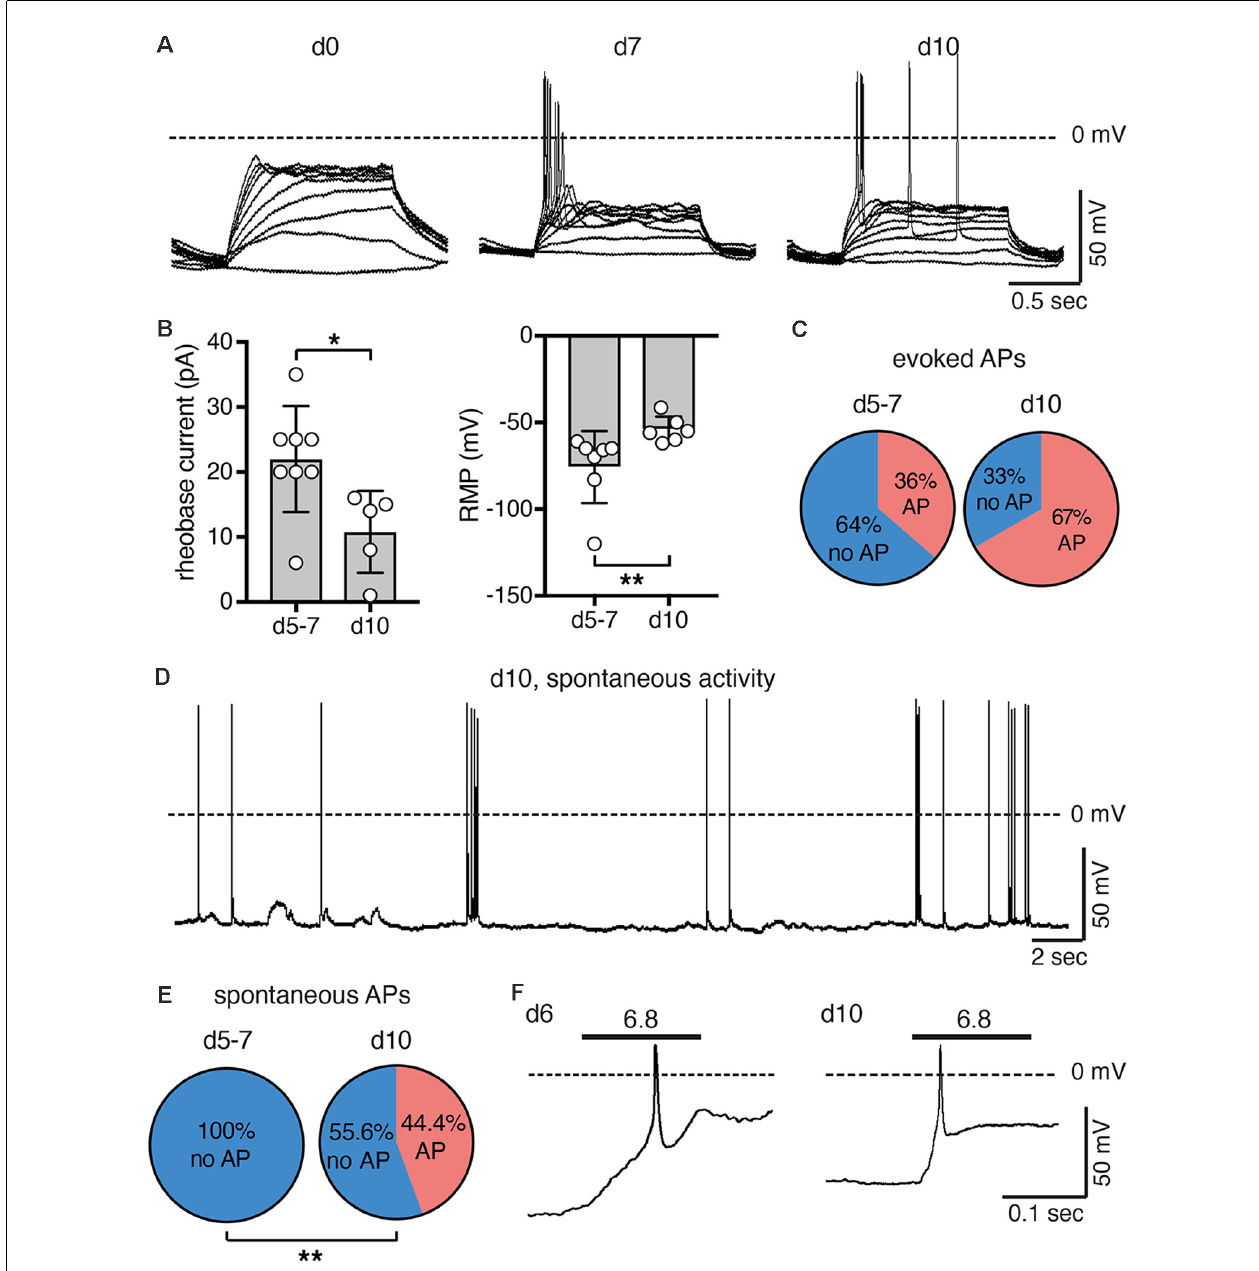
FIGURE 5 | Excitability of LUHMES cells during differentiation. (A) Representative current clamp recordings from LUHMES cells on d0, d7 and d10. Depolarizing step current pulses elicited APs only in differentiated LUHMES cells. (B) Summary of the rheobase and the resting membrane potential (RMP) at different times of differentiation ( n = 5–8); * p < 0.05, ** p < 0.01 (Mann-Whitney test). (C) Pie chart illustrating the proportion of cells, which responded with APs after pulse stimulation, at d5–d7 (8 out of 22 cells) and at d10 (six out of nine cells). (D) Example of spontaneous APs from LUHMES cells at d10. The trace is representative for four out